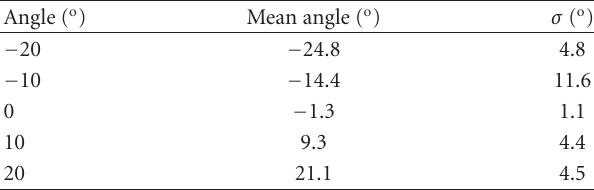
Table 6: Direction calibration data using mobile object detection.